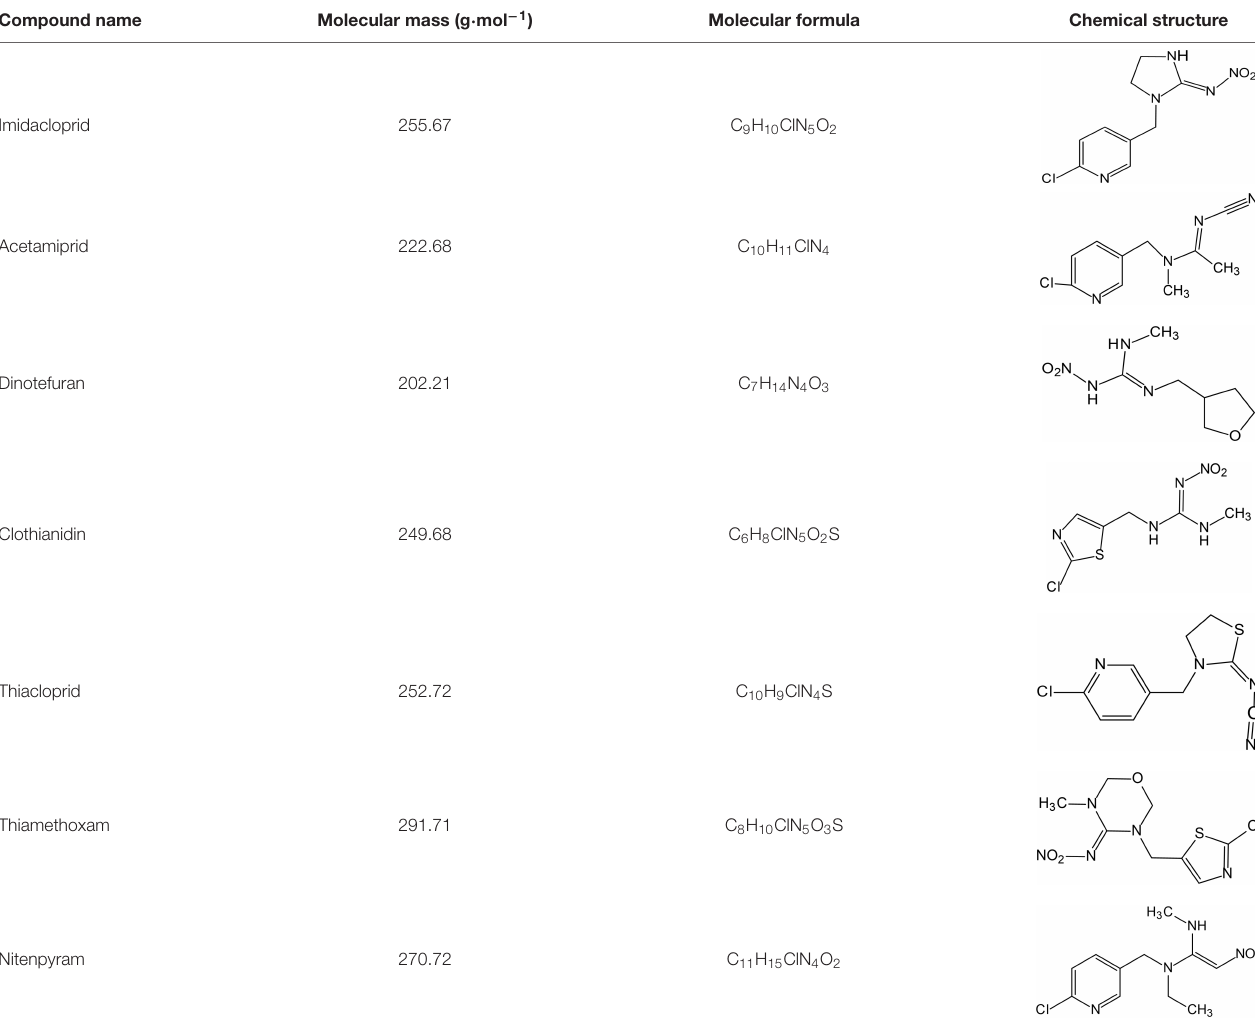
TABLE 1 | Neonicotinoid compounds and their chemical structures and molecular formulae. Compound